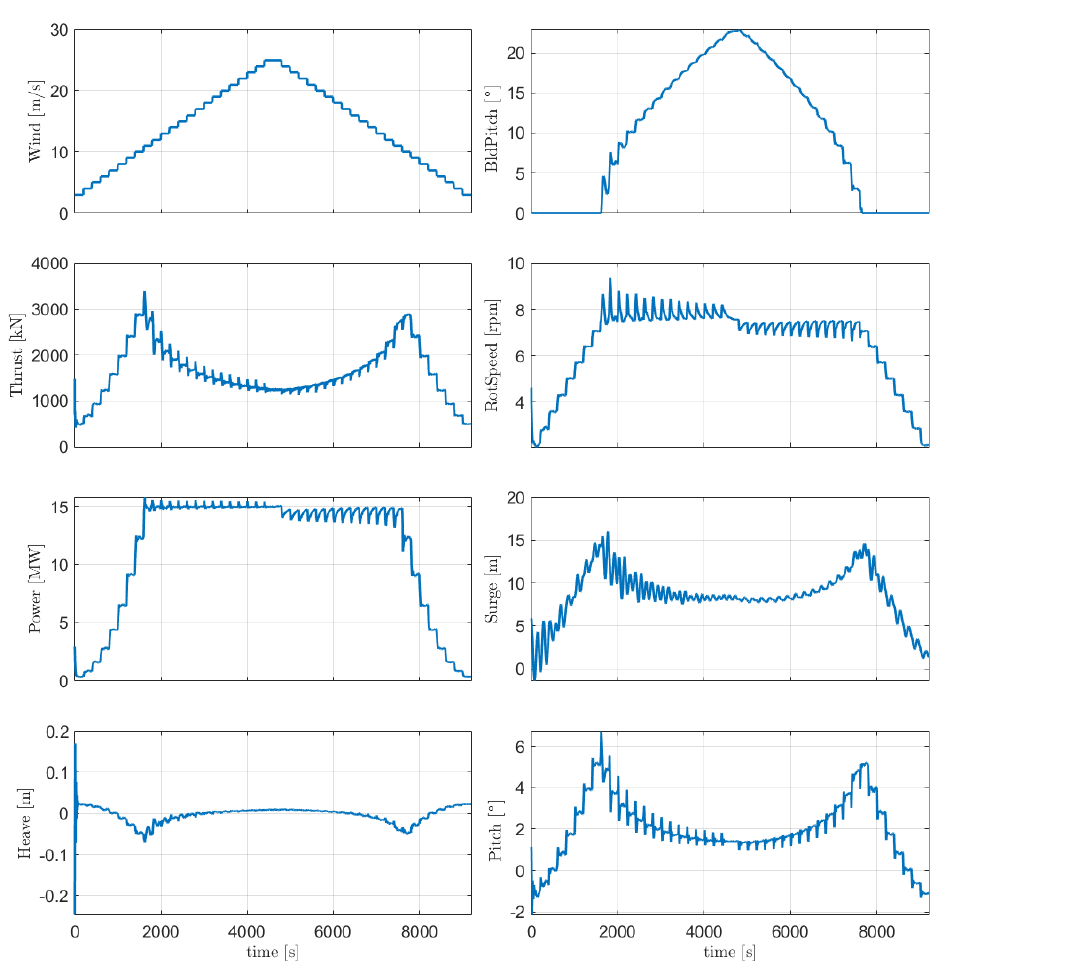
Figure A1. Activefloat response to step wind in the absence of